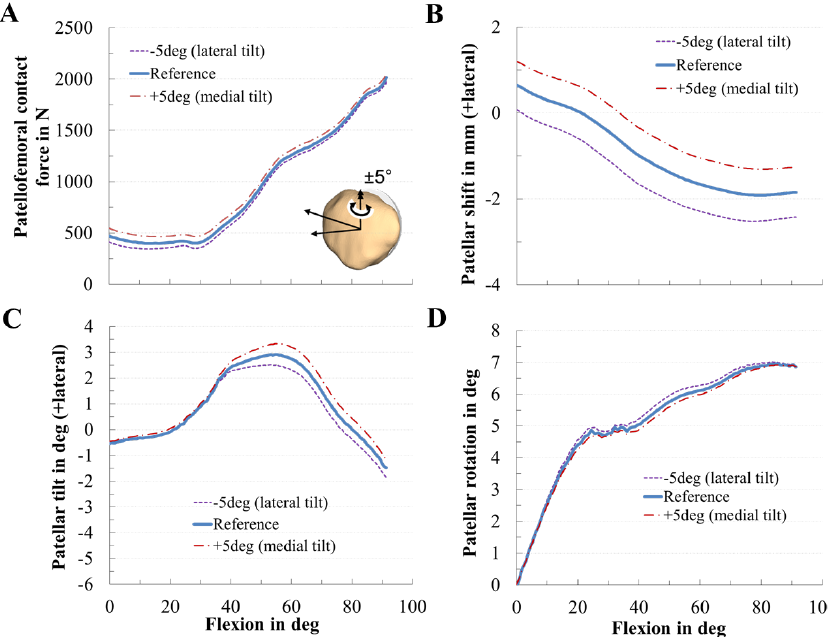
Figure 9. Effect of the tilting of the patellar component on patellofemoral dynamics. Effect of mediolateral positioning of the patellar component on patellofemoral contact force ( A ), patellar shift ( B ), patellar tilt ( C ), and patellar rotation ( D ).